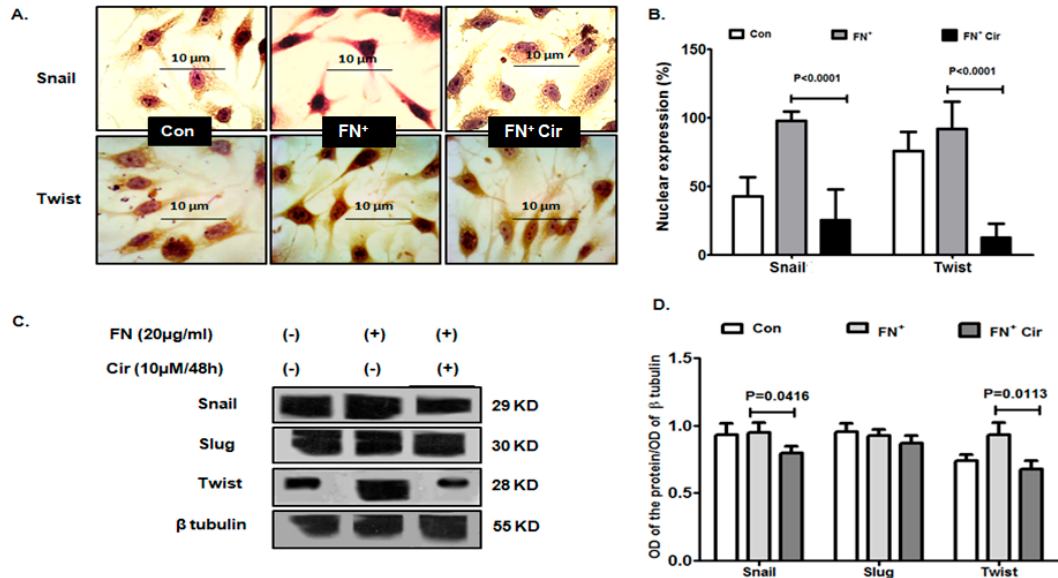
Figure 5. Effect of cirsiliol on the EMT transcription factors of B16F10 cells. ( A ) Representative micrographs of immunocytochemistry (400 × magnification) and ( B ) quantitative analysis of cells indicated reduced nuclear expression of Snail and Twist in FN + /Cir (10 µ M/48 h)-treated cells compared to FN + -induced cells. ( C ) Representative images of western blot and ( D ) the normalized mean band intensity graphs indicated reduced expression of Snail and Twist in FN + /Cir (10 µ M/48 h) treated cells in comparison with FN + -induced cells. Cir: cirsiliol; FN + : cells were seeded in pre-coated (cellular FN 20 µ g/mL for 2 h at 37 ◦ C) petri dishes and further incubated for 48 h in presence of 5% FBS for induction of EMT; FN + /Cir (10 µ M/48 h): cells were seeded in pre-coated (cellular FN 20 µ g/mL for 2 h at 37 ◦ C) petri dishes and treated with subjected to a non-cytotoxic dose of cirsiliol (10 µ M) treatment for 48 h. All quantitative results are expressed as mean ± SD based on three replicates.